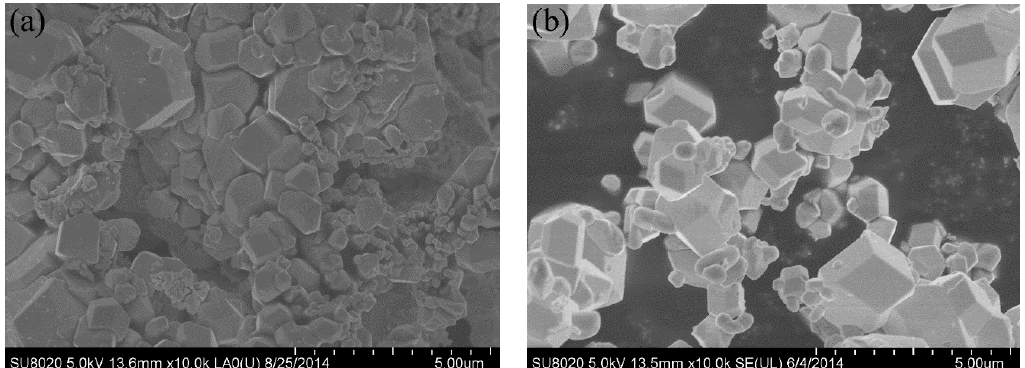
Figure 3. SEM images of the reduced powders showing bimodal morphology. ( a ) W–1 wt % Nd 2 O 3 ; ( b ) W–1 wt % CeO 2 .